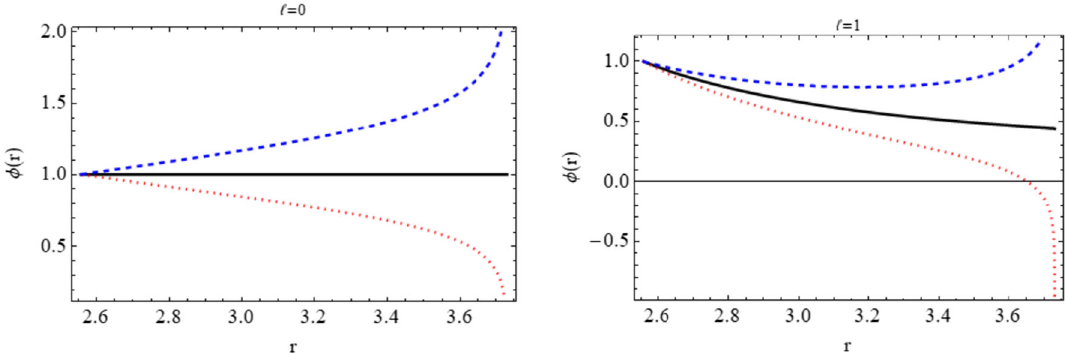
Fig. 11 The scalar field profile of the lowest state for α = bi f urcation point α c (black), a = α c + 0 . 5 (red) and a = α c − 0 . 5 (blue) with m = 0 , (cid:2) = 0 . 1. The left panel is for (cid:4) = 0 with α c = 0 while the right panel is for (cid:4) = 1 with α c = 4 . 63. Here we have set M = 1 and φ( r e ) = 1